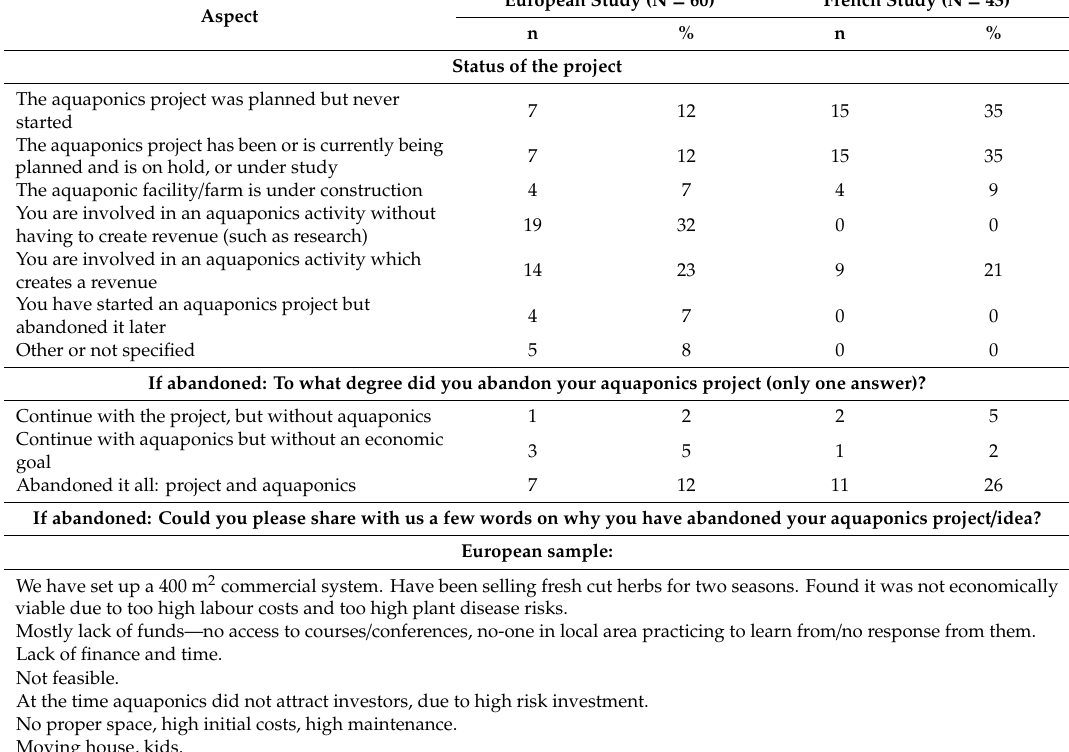
Table 5. Status of the project and reasons for abandonment. European Study (N = 60) French Study (N = 43) Aspect n % n % Status of the